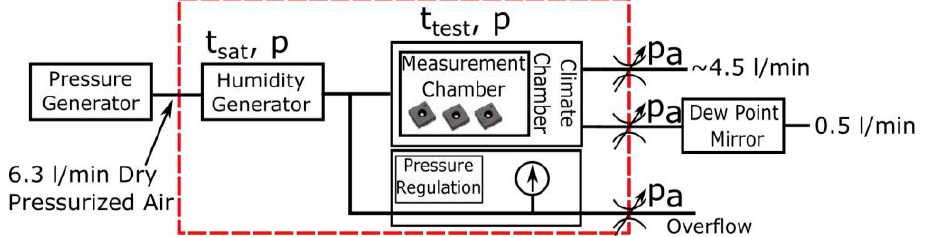
Figure 1. Schematic of measurement set-up showing the airflow from the pressure generator to the outlets. The part of the set-up inside the red dashed rectangle is pressure-controlled to pressure